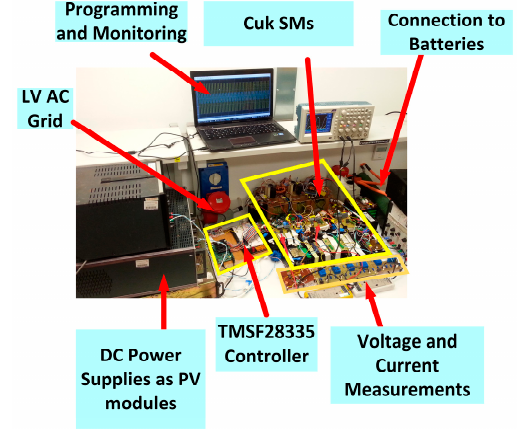
Figure 26. Experimental setup for CMC. Table 5. Parameters of the experimental setup.